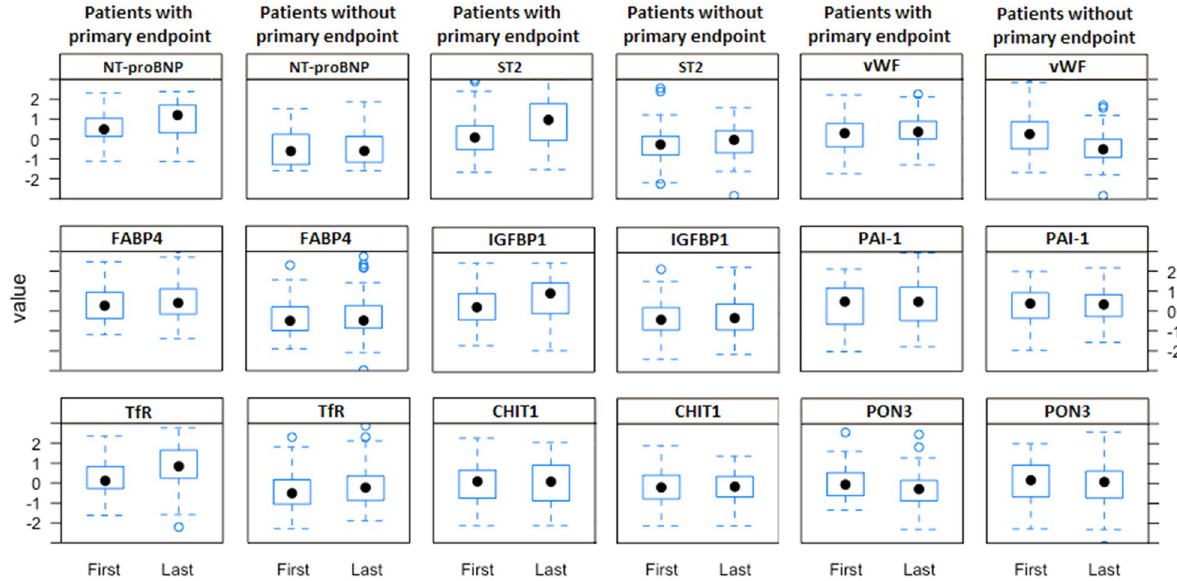
Chitotriosidase-1, FABP4 Fatty acid-binding protein 4, IGFBP-1 Insulin-like growth factor-binding protein 1, NT-proBNP N-terminal prohormone brain natriuretic peptide, PAI-1 Plasminogen activator inhibitor 1, PON3 Paraoxonase 3, ST2 protein Suppressor of tumorigenicity 2, TfR Transferrin receptor protein 1, vWF von Willebrand